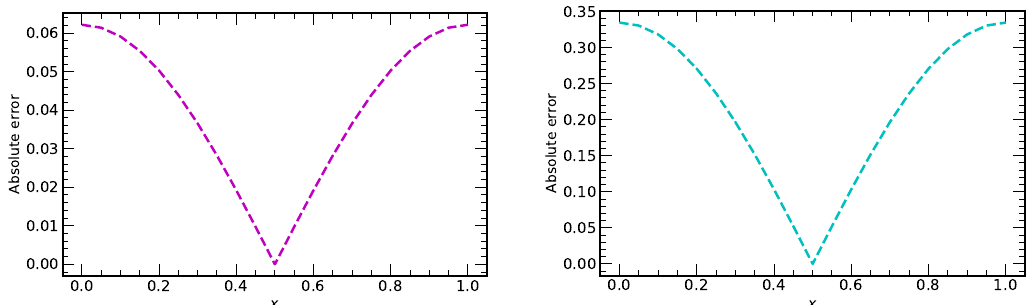
Figure 7. Plots of exact solution and approximate solution using HPM at different t -values, t = 0.05,0.07 (for numerical experiment 2).